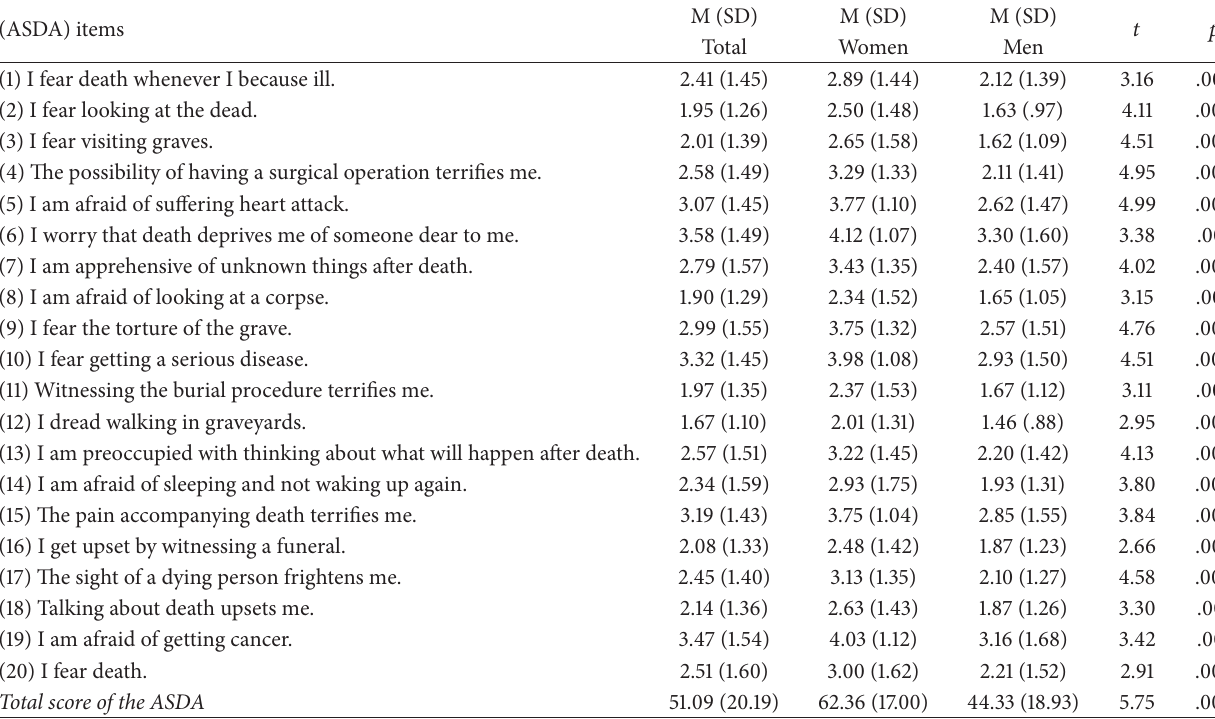
Table 1: Mean and standard deviation of the Arabic Death Anxiety Scale items in Iranian elders. (ASDA) items